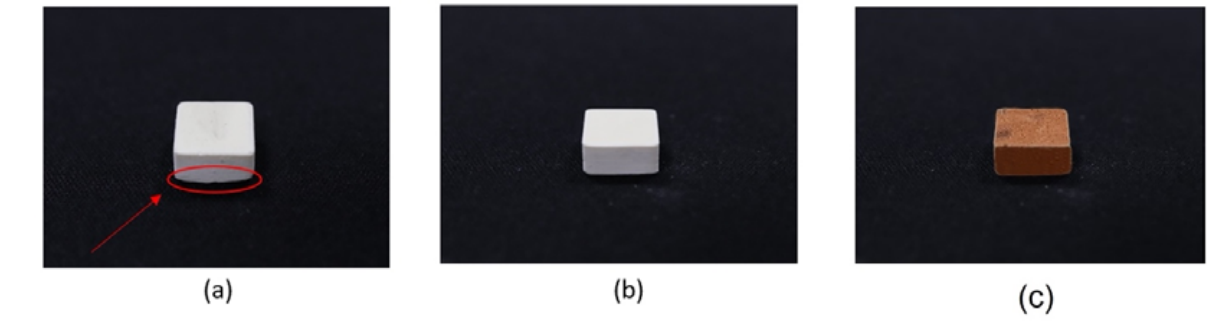
Figure 8. Printed specimens: ( a ) distortion at the corner of the LTCC green body, ( b ) successfully printed specimen with a 50 µ m layer thickness for ( b ) LTCC and ( c ) copper slurries. The dimensions of each printed specimen are measured and the specimens undergo sintering. Crack-free sintered parts are obtained using the proposed three-stage sintering parameters. Tables 2 and 3 list the dimensions of each specimen for LTTC and copper and the average shrinkage ratio in each axial direction. The respective average shrinkage ratios for the sintered LTCC and copper specimens in the X, Y, and Z axes are 30.84%, 31.18%, for these two slurries are very similar, which increases fusion when the two slurries are used to form a printed part and sintered